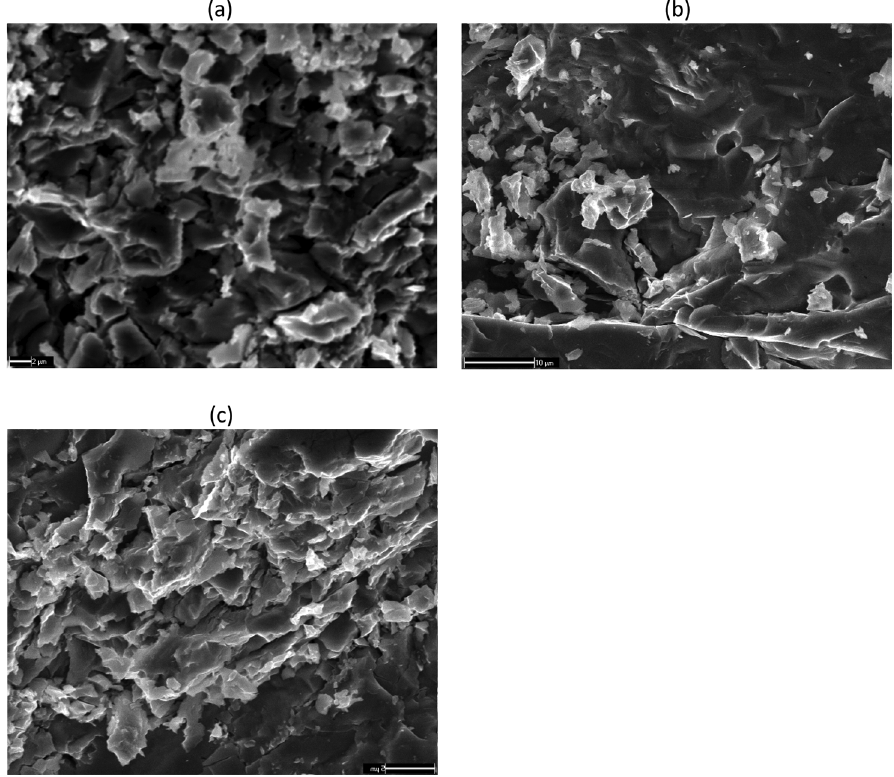
Figure 6 : Fracture surface of CrB 2 composites prepared by addition of (a) 2.5% Nb (b) 10% Nb (c) 20%